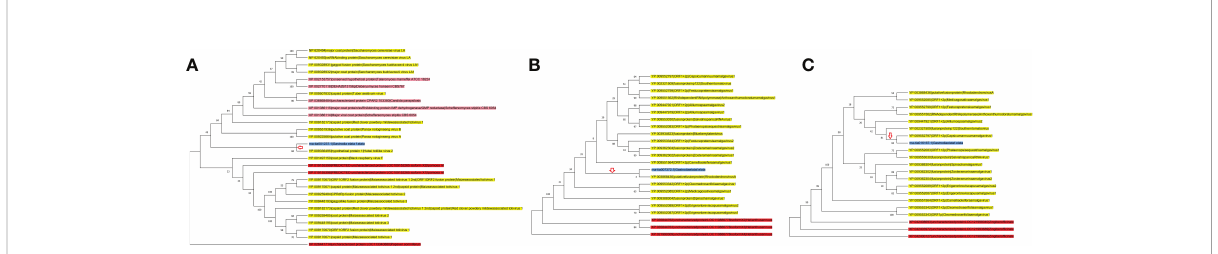
FIGURE 2 Maximum Likelihood (ML) phylogenetic tree of HGT homologs. (A) rna-tia001237.1; (B) rna-tia007372.1; (C) rna-tia016167.1. Terminal nodes highlighting with yellow, red, pink and blue backgrounds indicate viral, plant, fungi, and GE genes, respectively. Red arrow indicates HGTs, and numbers represent bootstrap